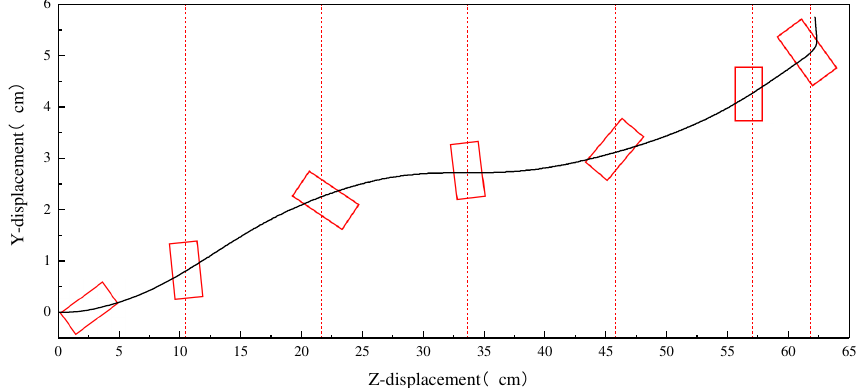
Figure 11. Trajectory of projectile in Test 3. (The red dash line is the dividing line of different stages)